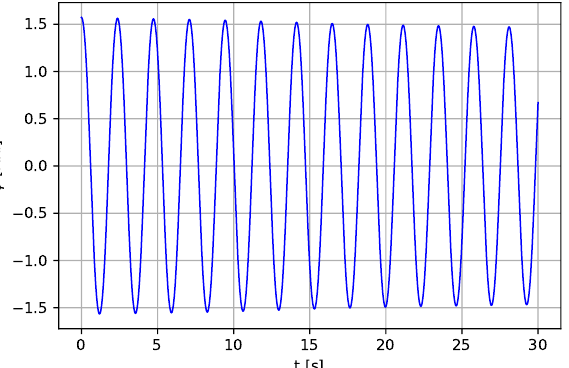
Figure 11. Linear displacement x pc of the piston l = 0.5 m, b = 0.003 N The analysis for different lengths is carried out for a deeper understanding of the relation between pendulum length and output of the system, which was not addressed in [5]. Changing the right-hand side pendulum length alone, i.e., without changing initial parameters of other parts, affects performance of the whole system. Therefore, the efficiency of the pumping depends on the length of the right-hand side pendulum. As can be seen in Figures 12–14, the system becomes more stable, but with a reduced number of oscillation periods for the whole system when the parameter value l is changed from 0.5 to 1.2 m.